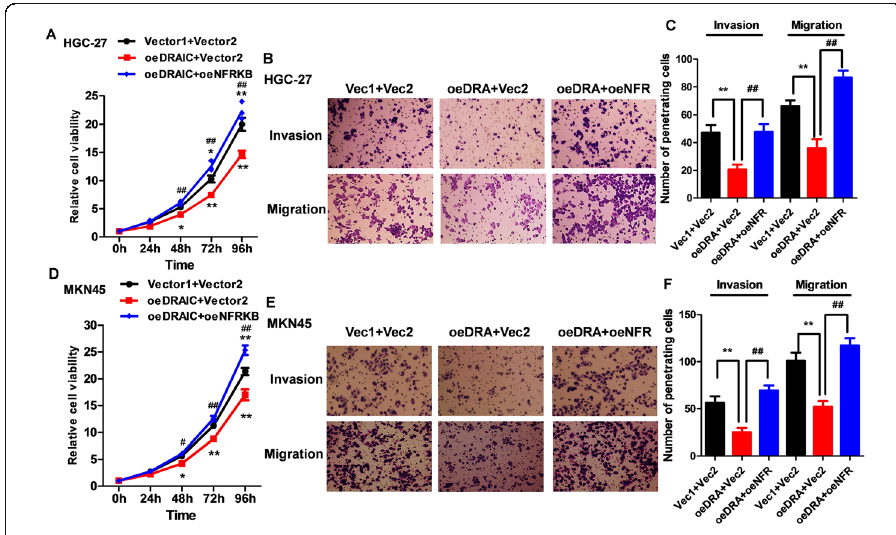
Fig. 5 Biological effects of oeDRAIC and oeNFRKB on GC cells. a. The effects of oeDRAIC and NFRKB rescued on HGC-27 cell proliferation. b. The effects of oeDRAIC and NFRKB rescued on HGC-27 cell metastasis. c. Quantitative results of ImageJ analysis Fig. 5b. d. The effects of oeDRAIC and NFRKB rescued on MKN45 cell proliferation. e. The effects of oeDRAIC and NFRKB rescued on MKN45 cell metastasis. f. Quantitative results of ImageJ analysis Fig. 5e. Quantitative data are presented as means ± SD. * P < 0.05, ** P < 0.01 compared with the vector1 + vector2 group, ## P < 0.01 compared with the oeDRAIC+vector2